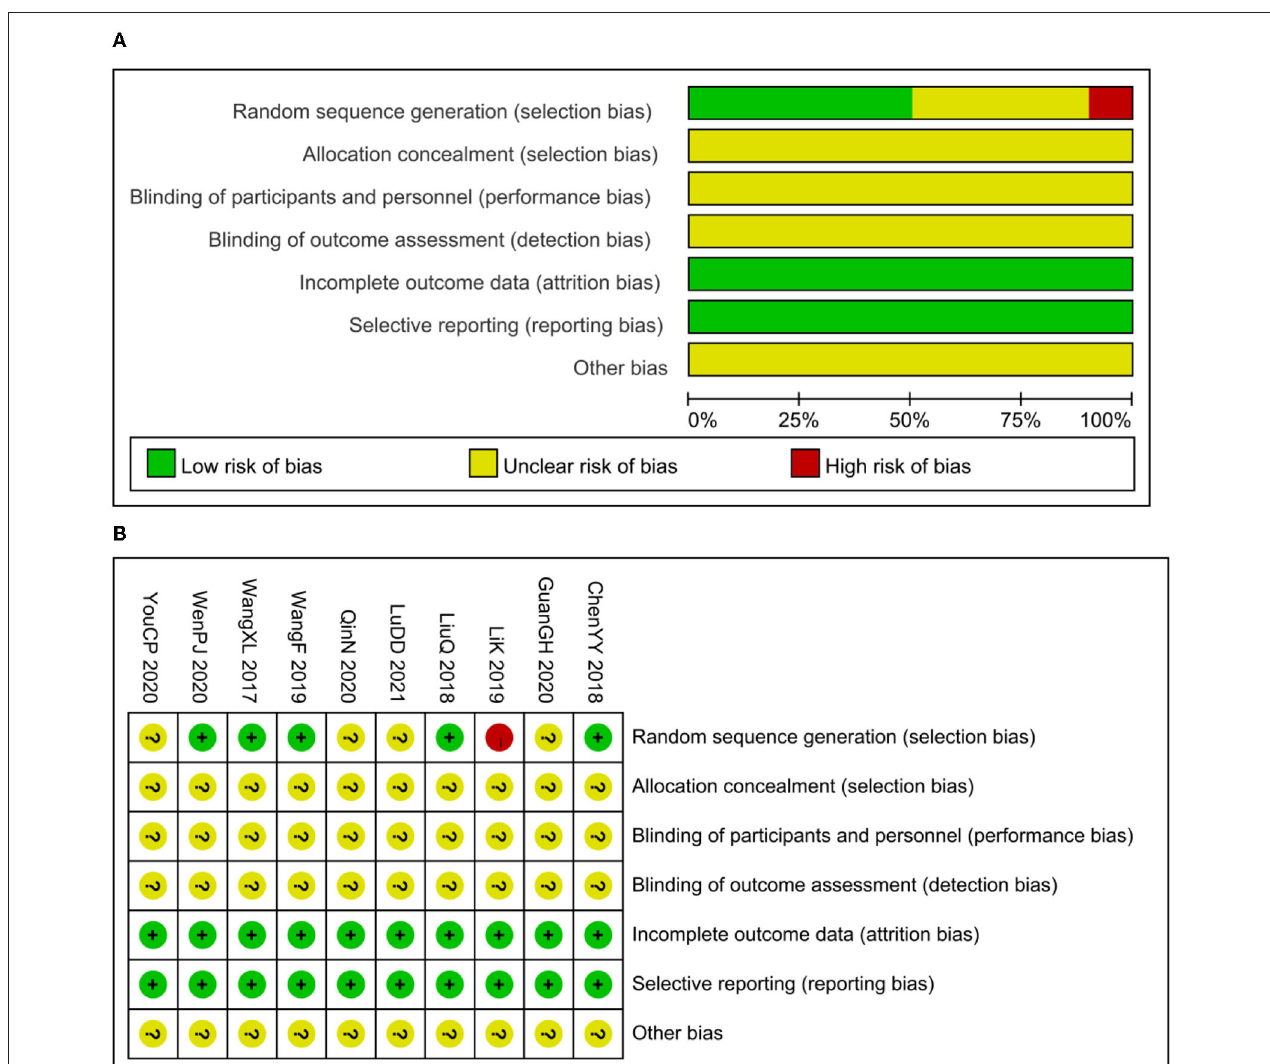
FIGURE 2 | Assessment of risk of bias. (A) Risk of bias graph and (B) risk of bias